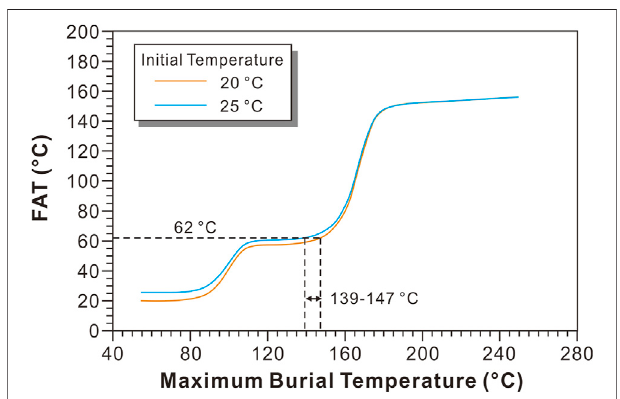
FIGURE 6 | Relationship between the fi nal apparent temperature (FAT) and the maximum burial temperature of the limestone from the Xibeixiang (XBX)outcrop,assuming that thecalcite crystalized at 20and 25 ° Cat 270 Ma using Stolper and Eiler (2015) solid-state reordering model for calcite.